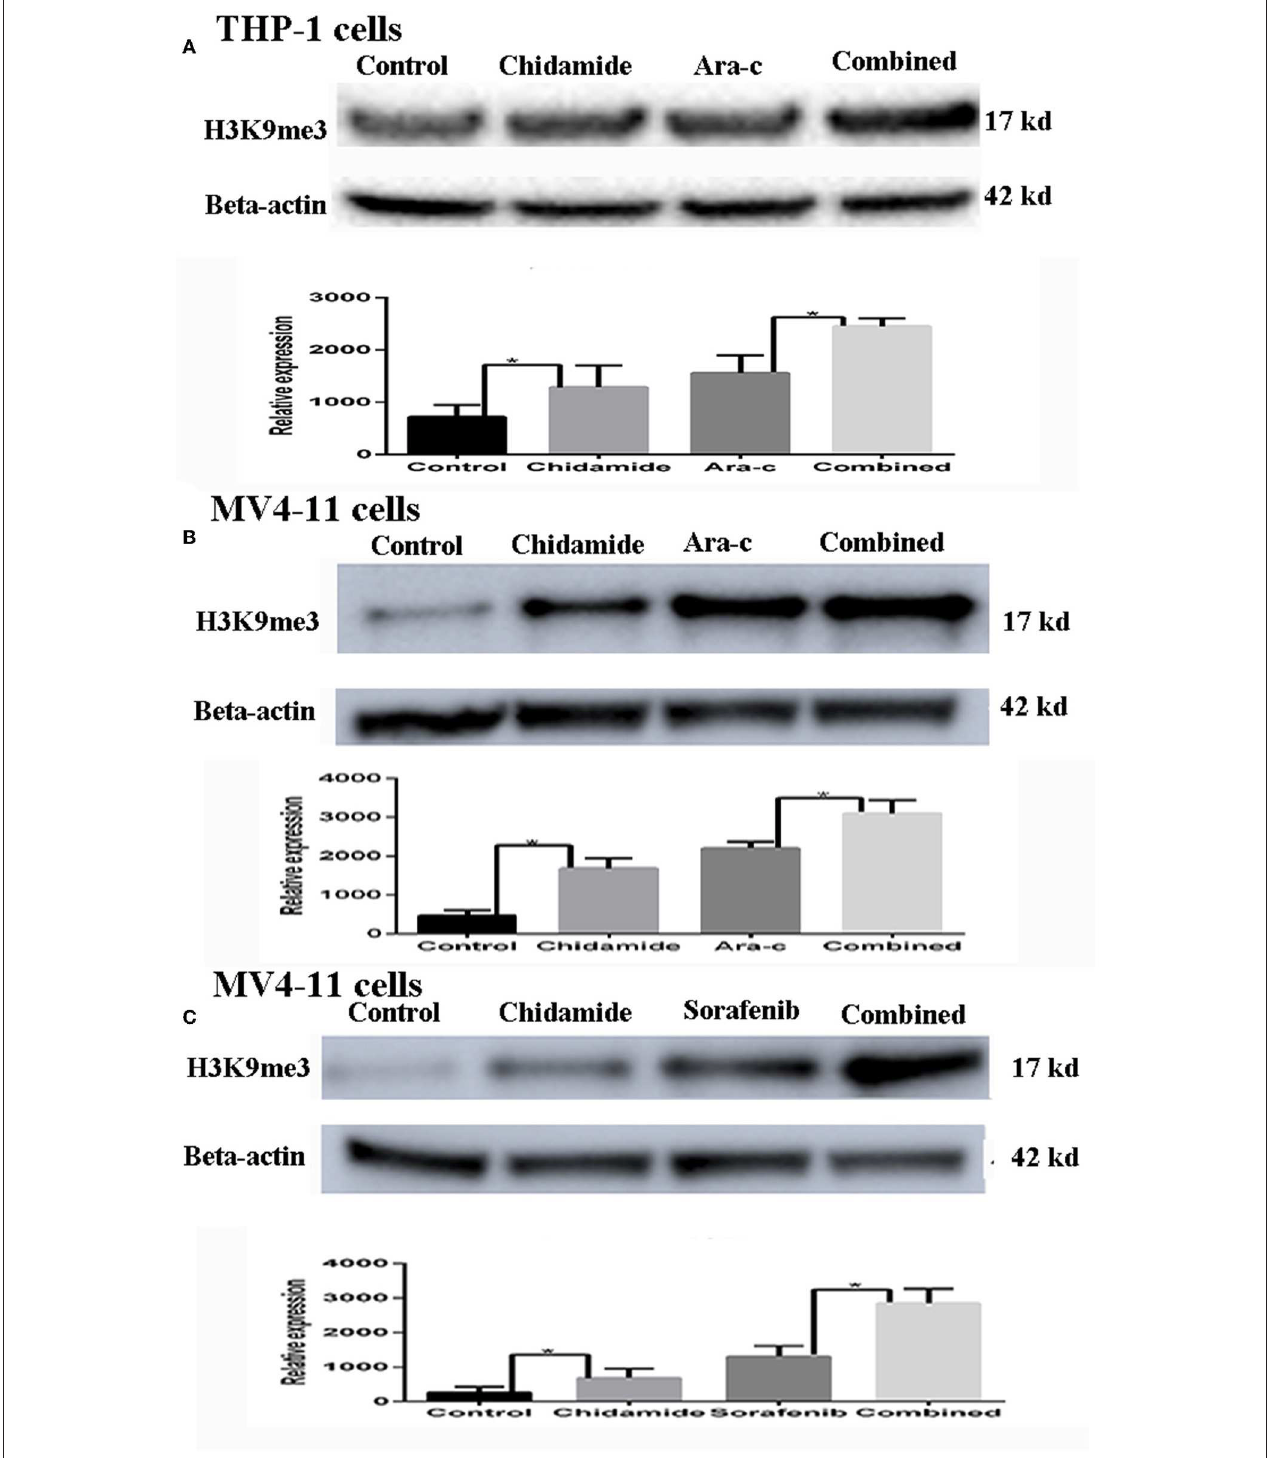
FIGURE 2 | The effect of chidamide on H3K9me3 levels in acute myeloid leukemia cells. (A) Western blot analysis of H3K9me3 levels was performed in THP-1 cells treated with Ara-c or in combination with chidamide, and relative expression level of H3K9me3 increased in THP-1 cells treated in combination with chidamide team compared THP-1 cells treated with Ara-c alone. (B) Western blot analysis of H3K9me3 was performed on MV4-11 cells treated with Ara-c alone or in combination with chidamide for 24h, and the relative expression level of H3K9me3 for MV4-11 cells in combination with chidamide team was higher than MV4-11 cells treated with Ara-c alone. (C) Western blot analysis of H3K9me3 was performed on MV4-11 cells treated with sorafenib alone or in combination with chidamide for 24h, and the relative expression level of H3K9me3 for MV4-11 cells in combination with chidamide team was higher than MV4-11 cells treated with sorafenib alone * p < 0.05.